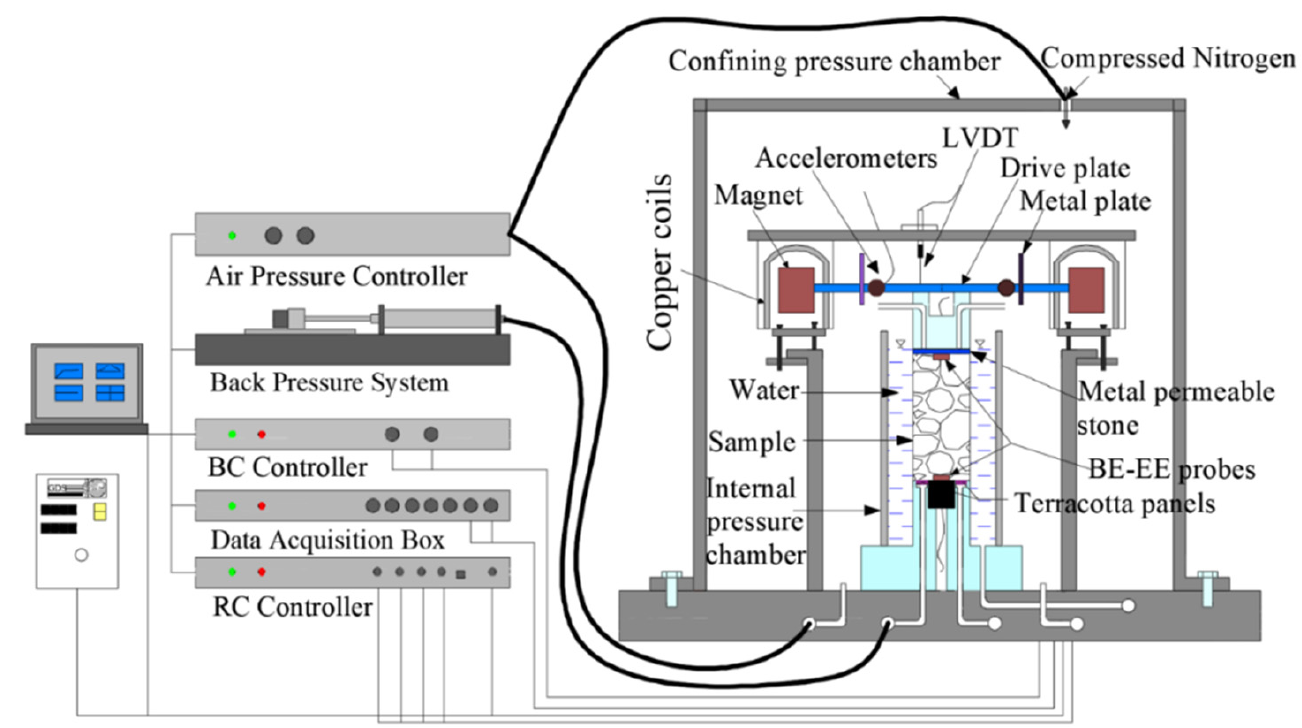
Figure 2. Schematic diagram of the general assembly of the BE-EE-RC test system.